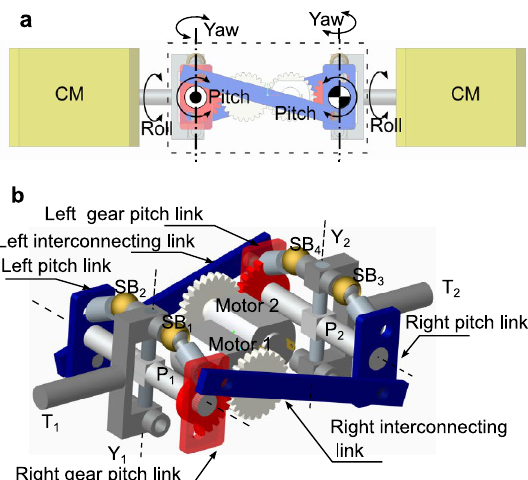
Fig. 5 The idea behind WORMESH-II’s joint mechanism. a Connection between two CMs. b Conceptual design of